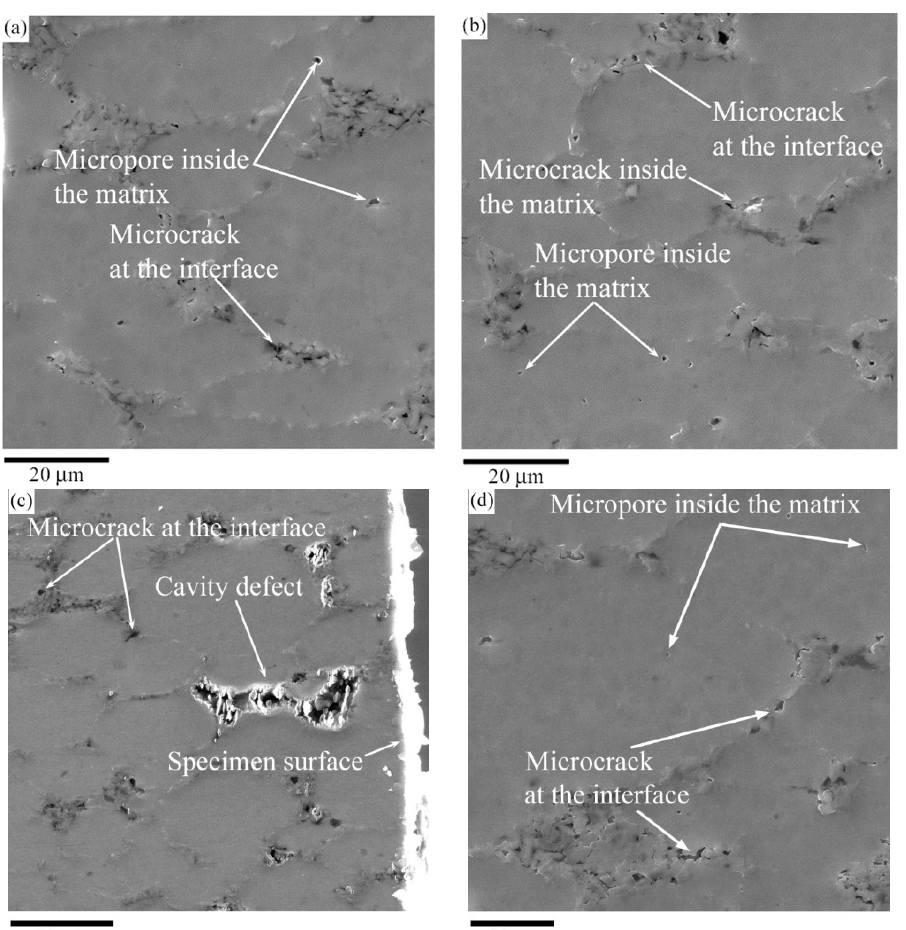
Figure 9. The microstructure near the side surface of the sintered V95/10% SiC MMC specimen after compression at temperatures of 300 ◦ C and D E = 0.28 ( a ), 400 ◦ C and D E = 0.27 ( b ), 500 ◦ C and D E = 0.28 ( c , d ). The images were obtained from a longitudinal thin section with a plane passing through the symmetry axis of the specimen (see Figure 2).